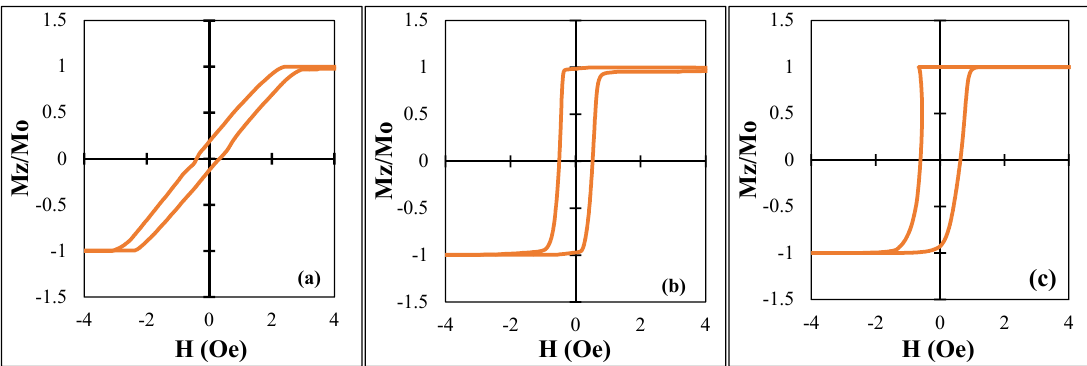
Figure 6. Hysteresis loops in a magnetic field along the wire axis for all the samples: ( a ) − 1, ( b ) − 2, and ( c ) − 3. M z is the magnetization component along the wire, M 0 is the saturation